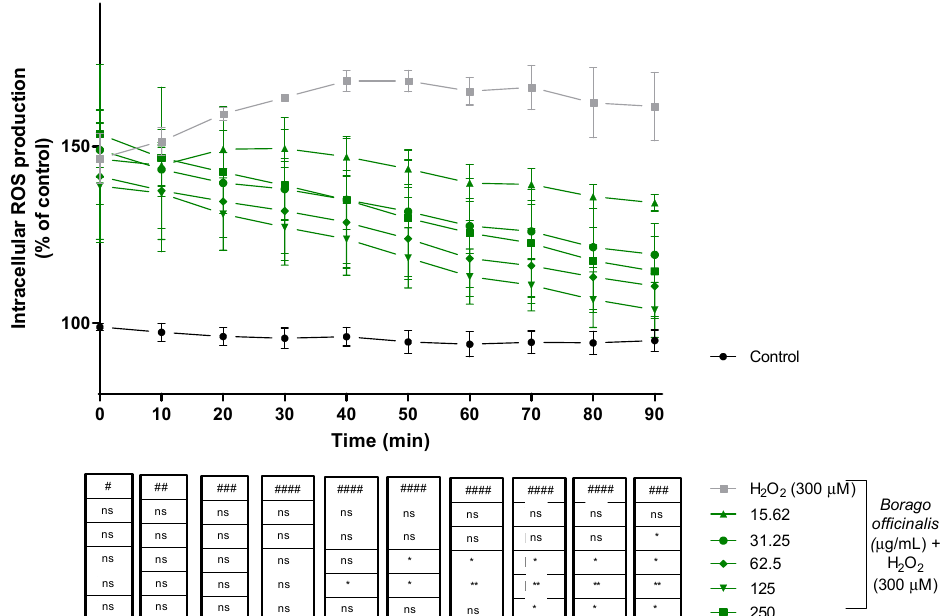
Figure 2. Production of ROS in Neuro-2a cells treated with hydrogen peroxide and Borago officinalis flower extract (15.62–250 µg/mL). Data are expressed as percentage over control cells. Note: # p < 0.05 versus control; ## p < 0.01 versus control; ### p < 0.0005 versus control; #### p < 0.0001 versus control; ns: no significant; * p < 0.05; ** p < 0.01. Borage co-treatment did not show any difference until 40 min (125 µg/mL; p < 0.05). From this point, ROS species were diminishing for all extract treatments and significant differences were increased. At the end of the experiment, only 15.62 µg/mL did not achieve any significant differences. Borago officinalis flower extract (125 µg/mL) reduced ROS production almost to basal levels (control cells).